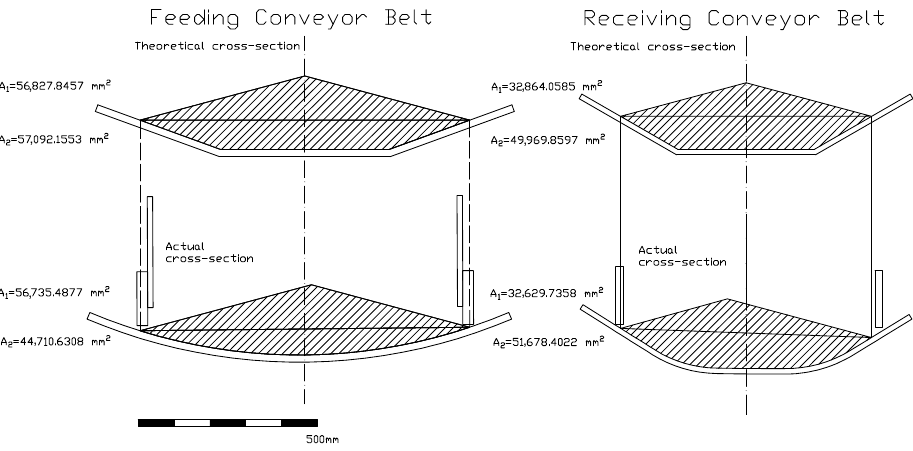
Figure 6. Cross-section of loaded conveyor